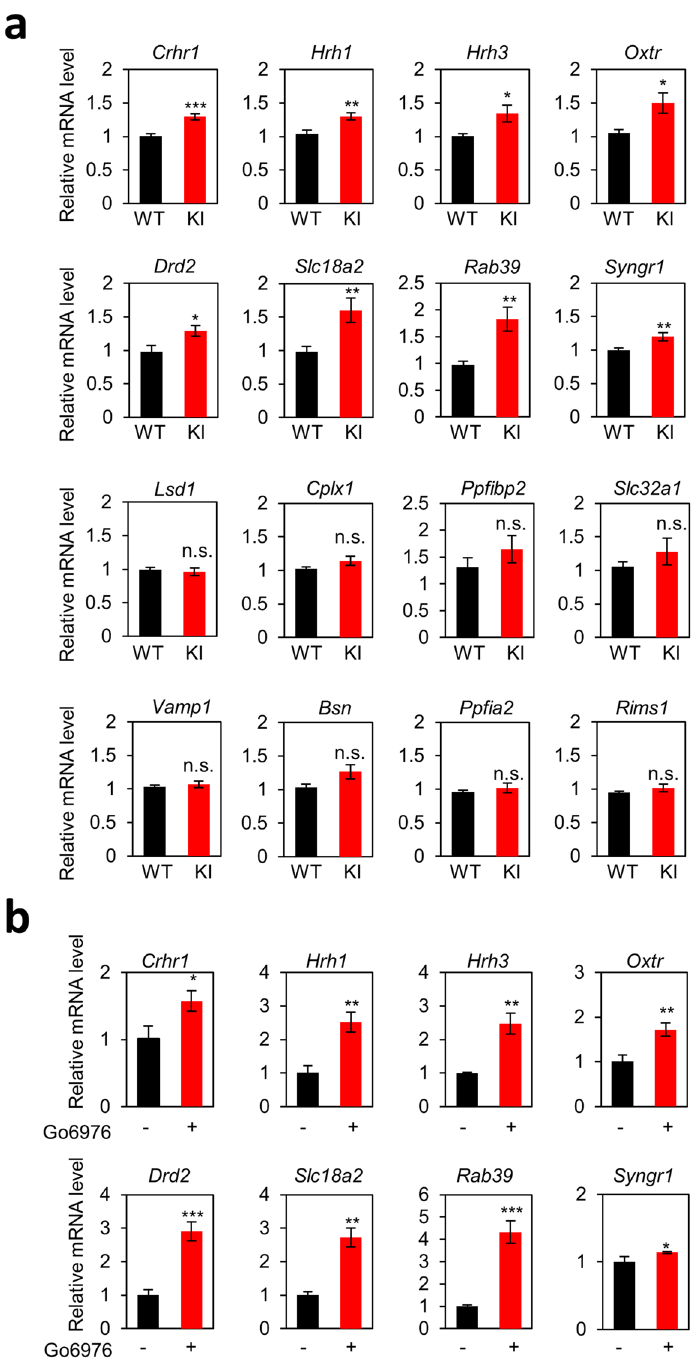
Figure 7. Quantitative RT-PCR analysis of differential gene expression in the hippocampal tissues and cultures. ( a ) Quantitative RT-PCR analysis of differential gene expression showed in RNA-seq analysis in the hippocampus of Lsd1 WT and KI mice (WT: n = 9, KI: n = 9; unpaired t -test, * p < 0.05, ** p < 0.01, *** p < 0.001, ns: not significant). Data are expressed as mean ± SEM. ( b ) Quantitative RT-PCR analysis of the changes in gene expression in mouse hippocampal cultures after treatment with Go6976 (100 nM, 8 h), a PKC α inhibitor. (n = 3; unpaired t -test, * p < 0.05, ** p < 0.01, *** p < 0.001) Data are expressed as mean ±